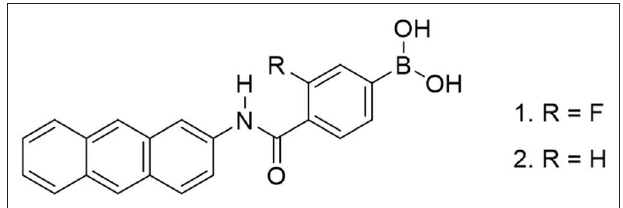
FIGURE 1 | Chemical structure of anthracene boronic acid